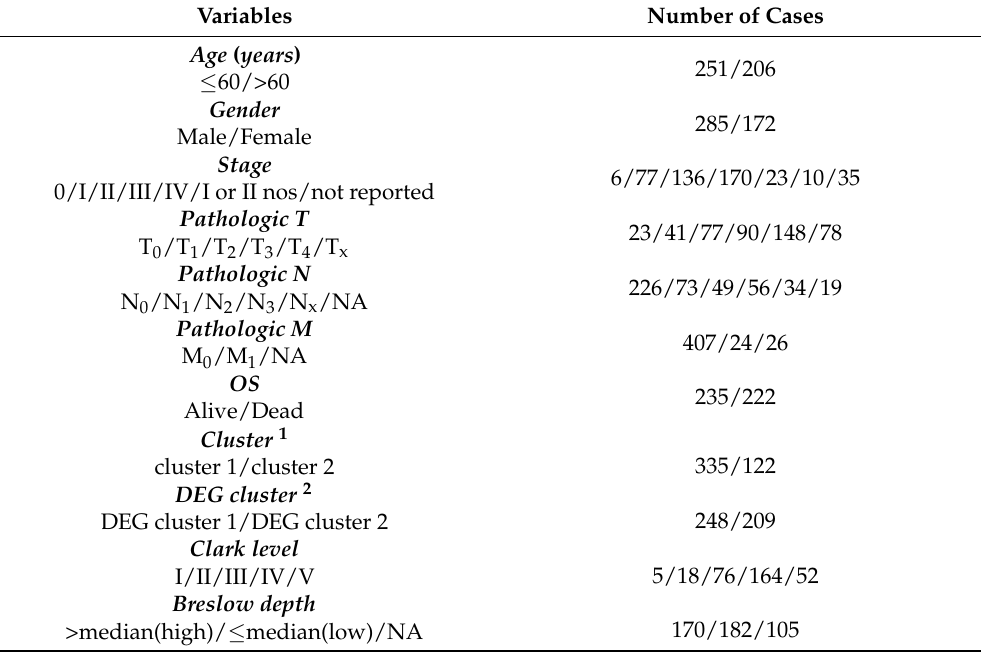
Table 1. Characteristics of patients in TCGA-SKCM.